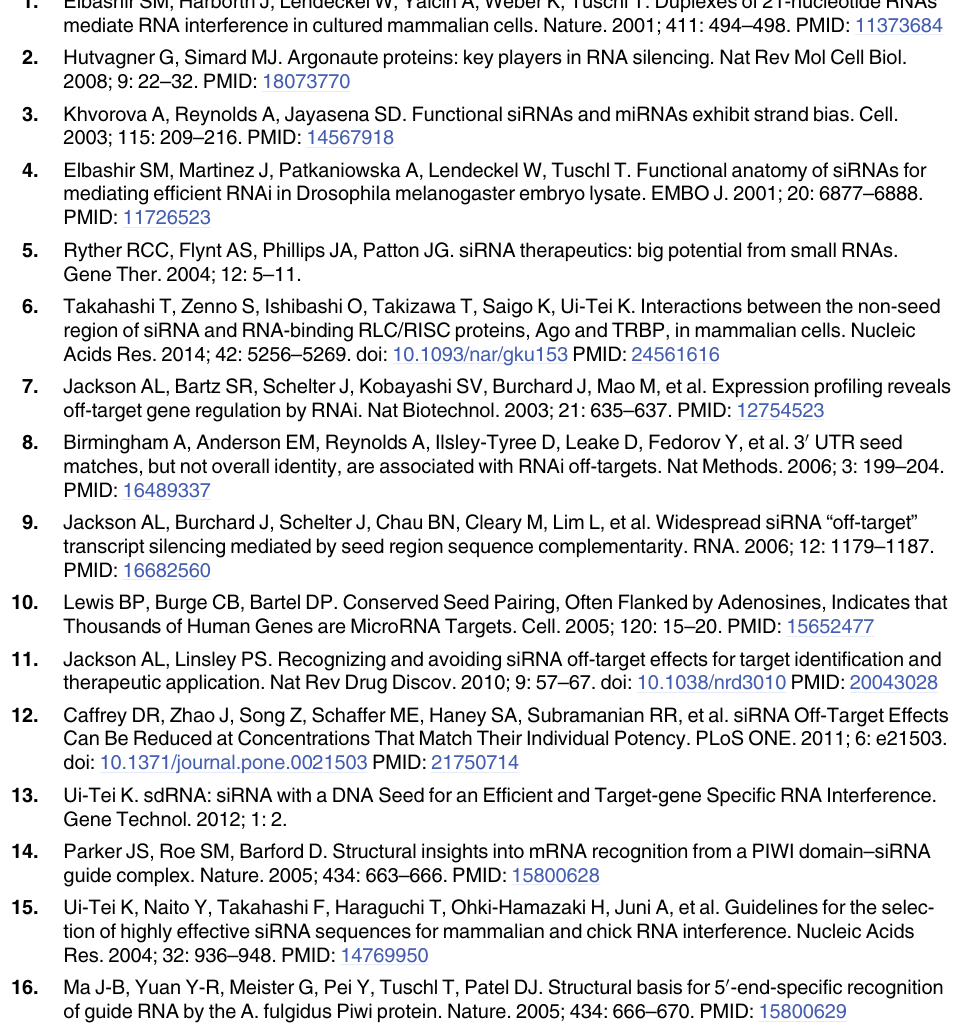
S1 Table. A list of siRNA molecules used in the heatmap